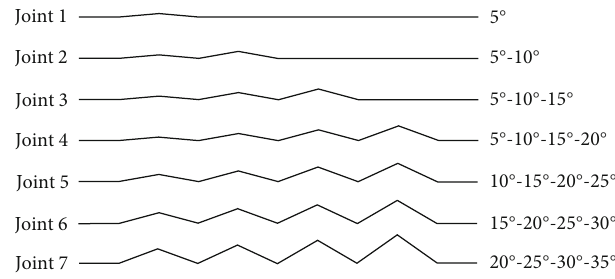
Figure 1: Schematic diagram of irregular rock joint pro fi